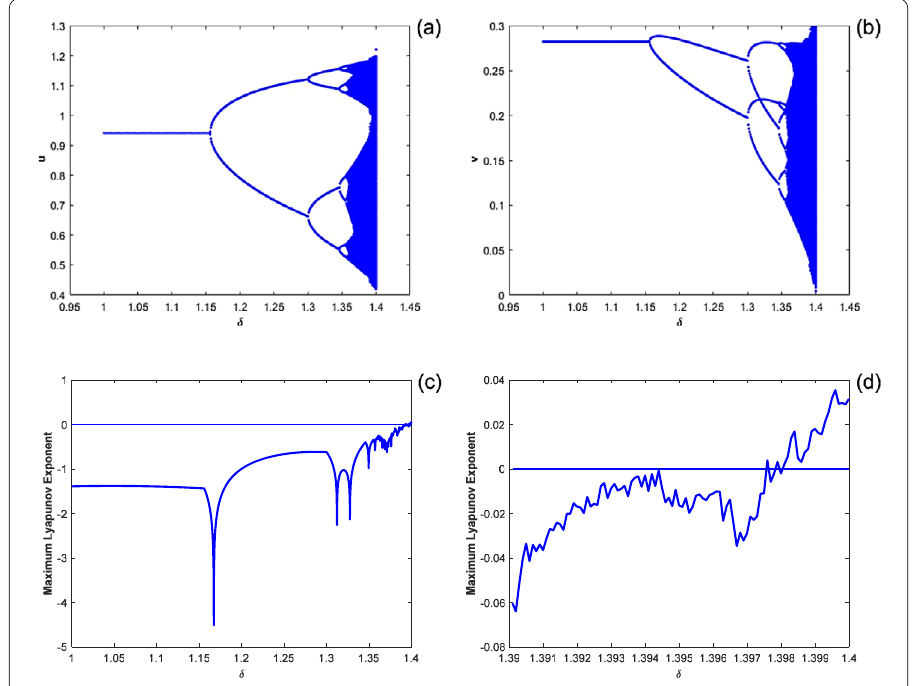
Figure 1 ( a ) Flip bifurcation diagram of map (3) in the ( δ , u ) plane with initial value (0.9510621,0.29231863). ( b ) Flip bifurcation diagram of map (3) in the ( δ , v ) plane. ( c ) Maximum Lyapunov exponents corresponding to ( a ) and ( b ). ( d ) Local amplification of ( c ) for δ ∈